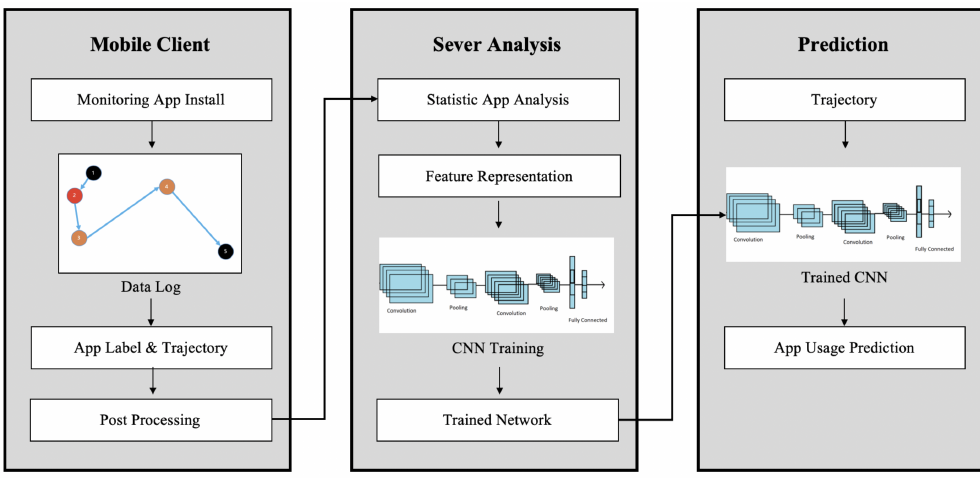
Figure 1. Schematic diagram of the proposed overall